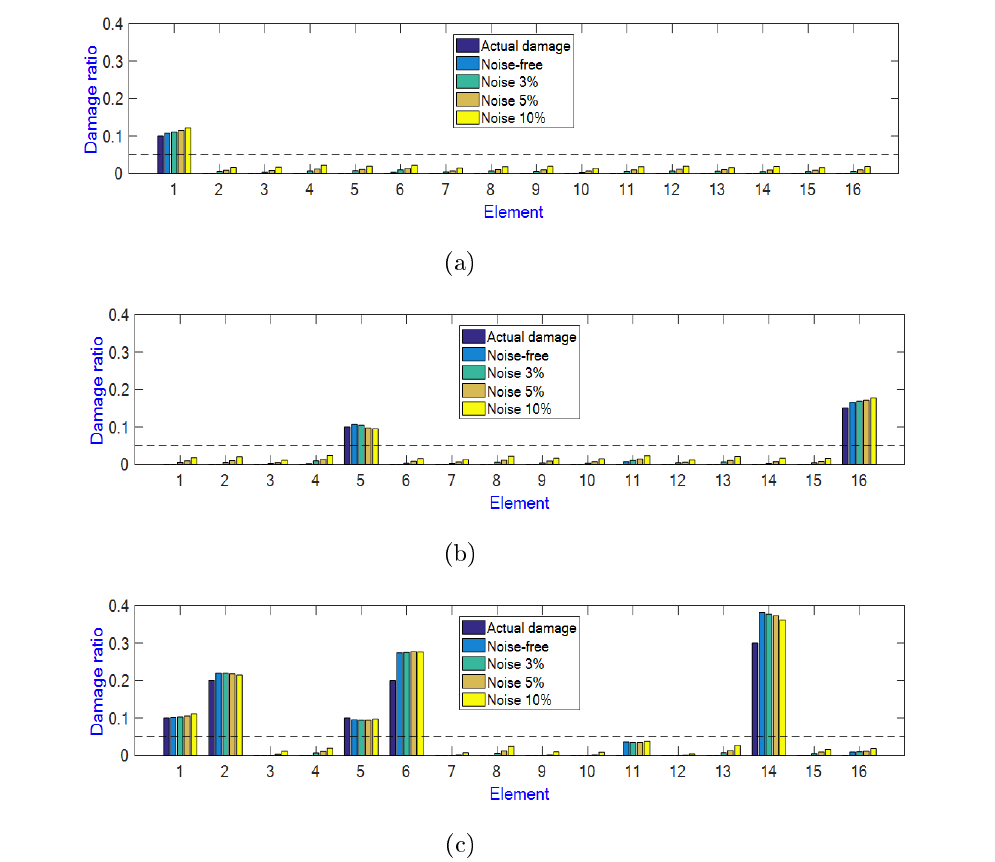
Fig. 2. Damage identi(cid:28)cation results obtained by damage indicator MKECR for three hypothetical damage scenarios of the clamped-clamped cross-ply ( 0 o / 90 o / 0 o ) beam: (a) Scenario A; (b) Scenario B; (c) Scenario C. G 23 = 0 . 5 E 2 , G 12 = G 13 = 0 . 6 E 2 , v 12 = 0 . 25